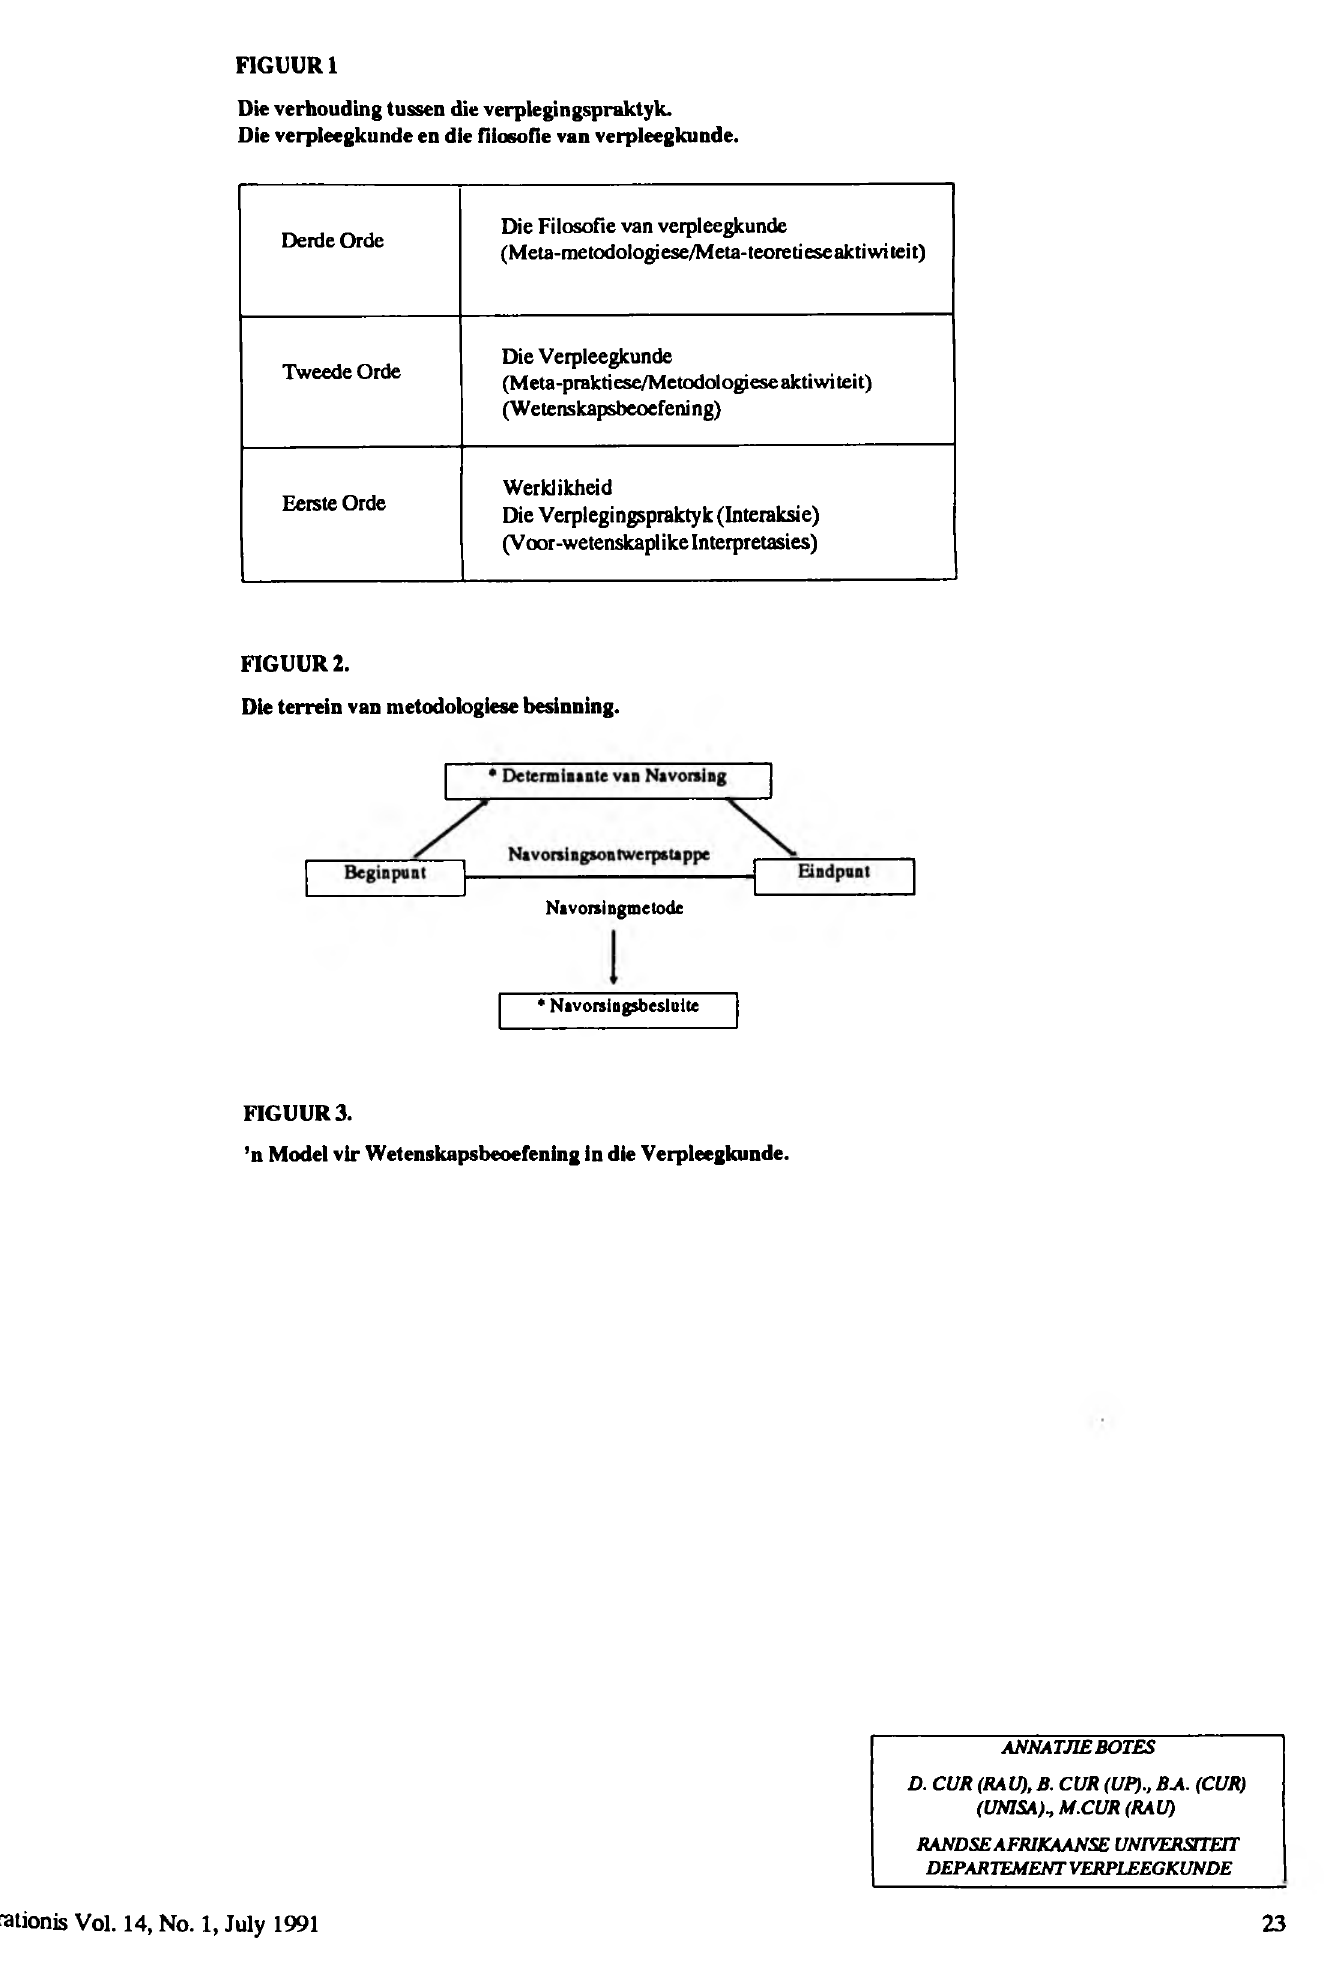
Die terrein van metodologiese